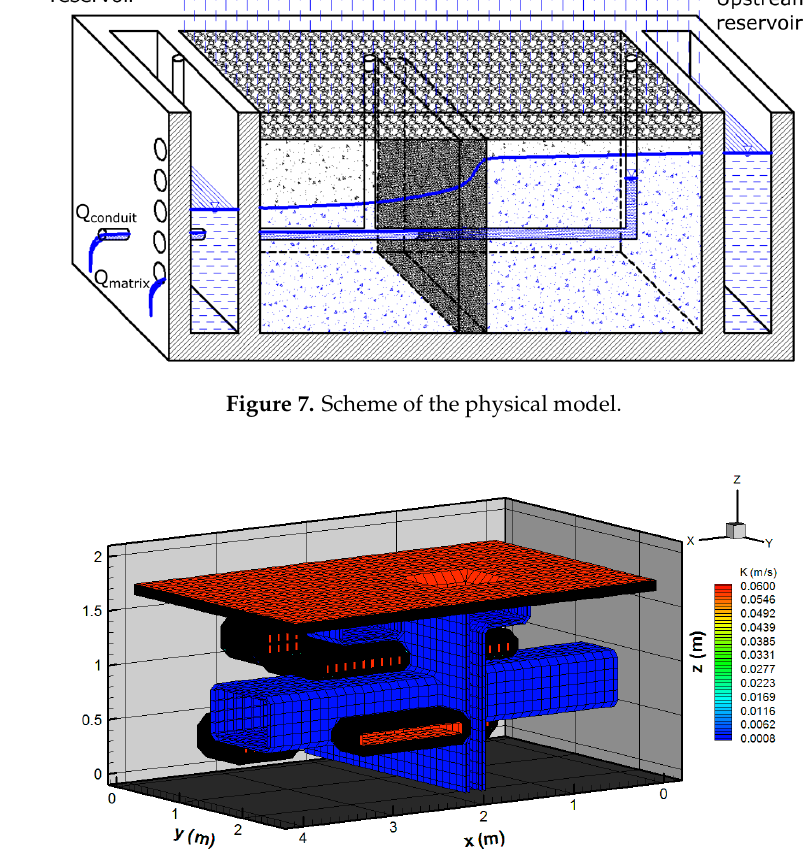
Figure 8. Heterogeneity of the porous